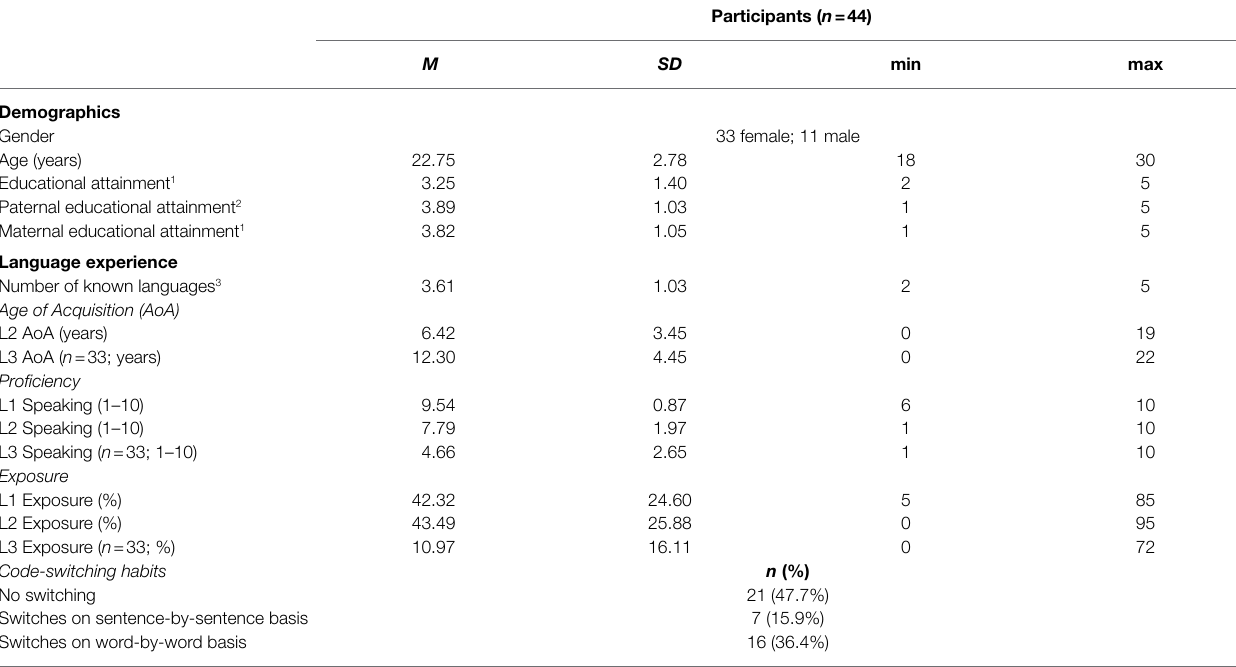
TABLE 1 | Participant demographics and language